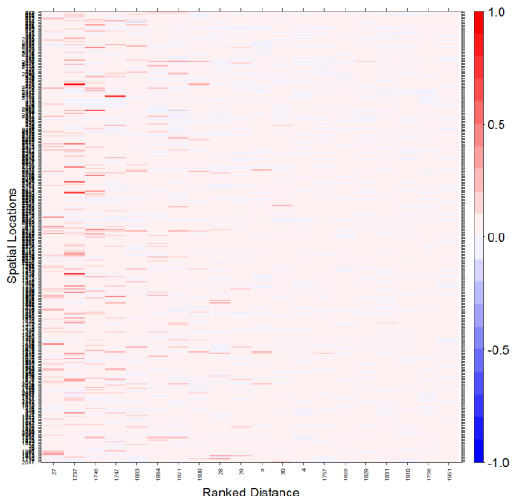
Figure 3. Cross-correlations ranked by network distance from the midpoint of each link.